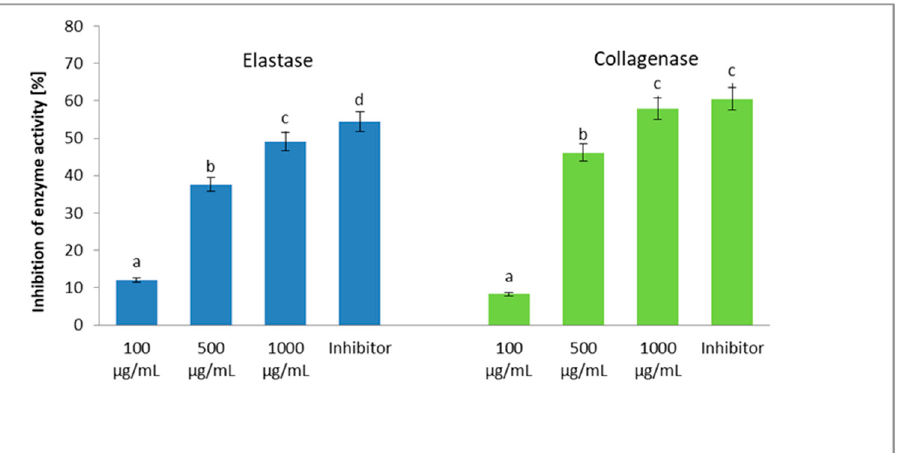
Figure 5. Influence of ethanolic extracts from E. angustifolium (FEE) on the elastase and collagenase inhibitions. SPCK for elastase and 1,10-phenanthroline for collagenase were used as the control inhibitors. Data are the mean ± SD of three independent experiments, each of which consisted of two replicates per treatment group. Vertical lines represent the standard deviation. Different letters—values are significantly different, α < 0.05.